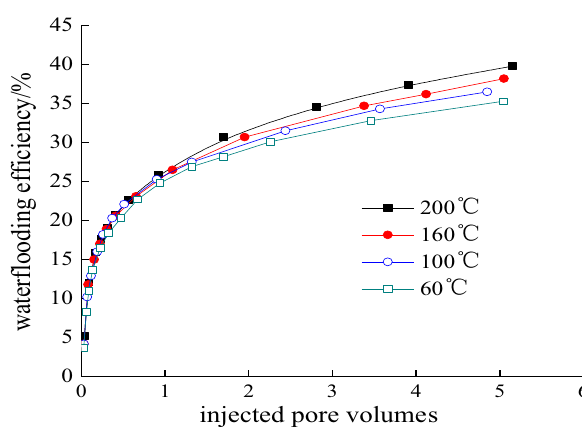
Fig. 8 Water flooding efficiency curve of the oil displacement experi- ments